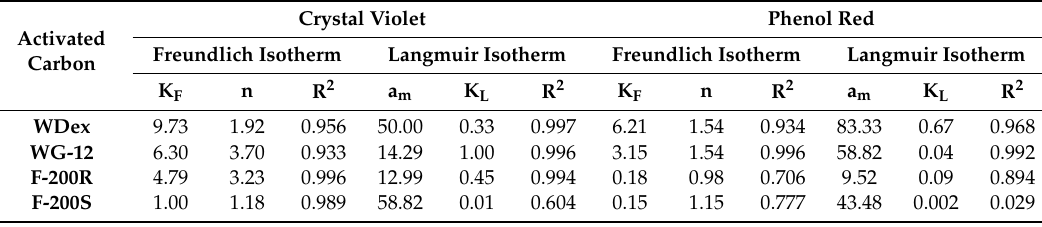
Table 1. Coe ffi cients of the Freundlich and Langmuir isotherms in relations to the adsorption of phenol red and crystal violet onto the investigated activated